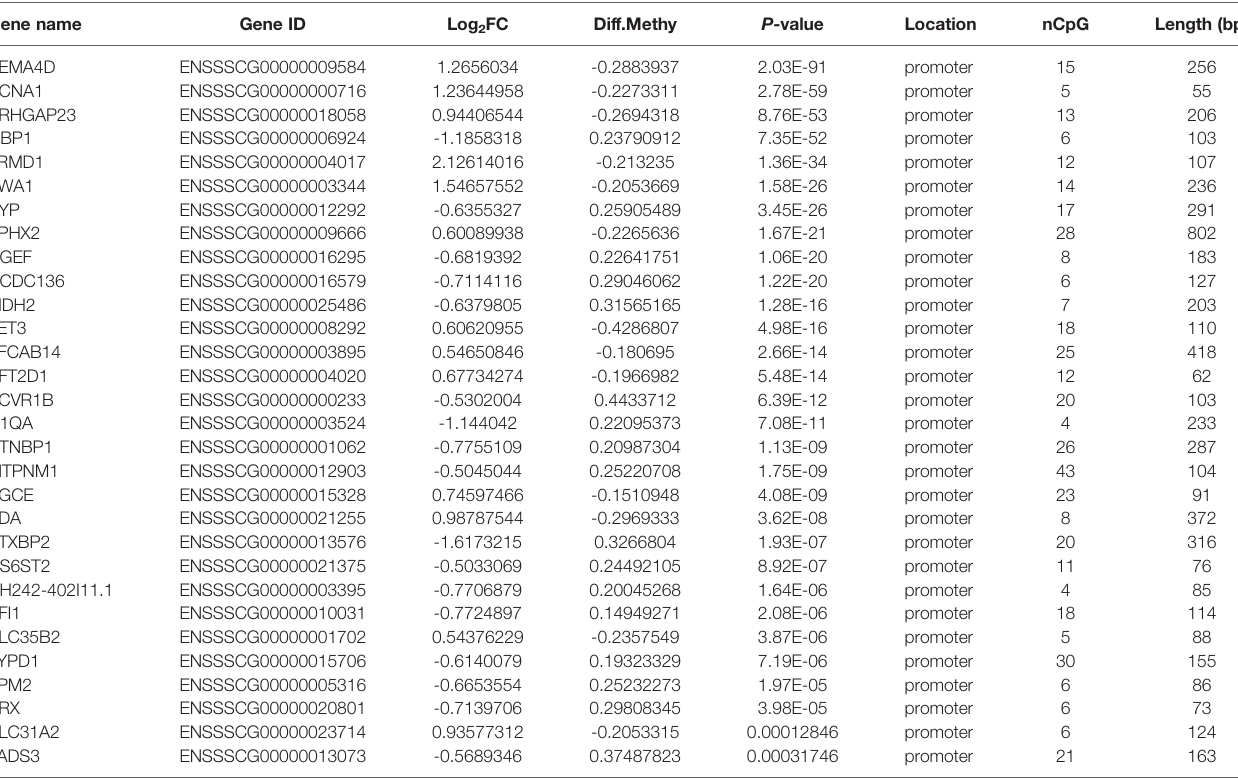
TABLE 1 | Top 30 genes with an inverse correlation between DMR and gene expression in G. parasuis- infected porcine